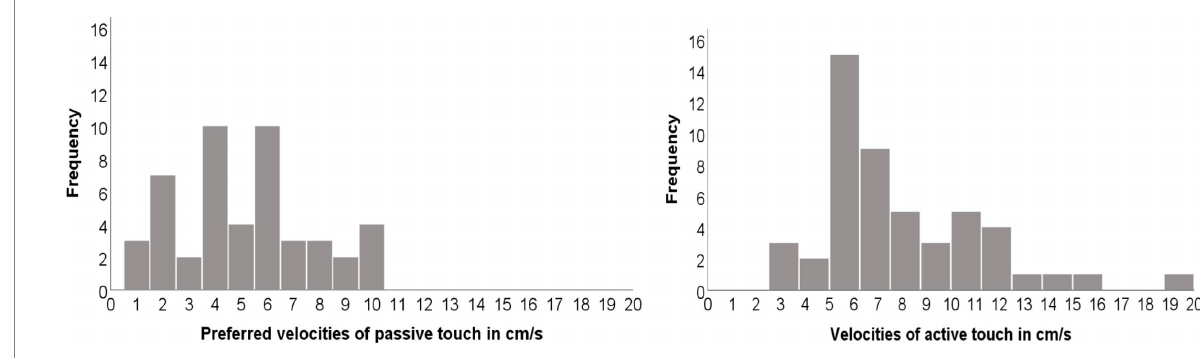
FIGURE 3 Distributions of preferred velocities of touch (left: passive touch; right: active touch).